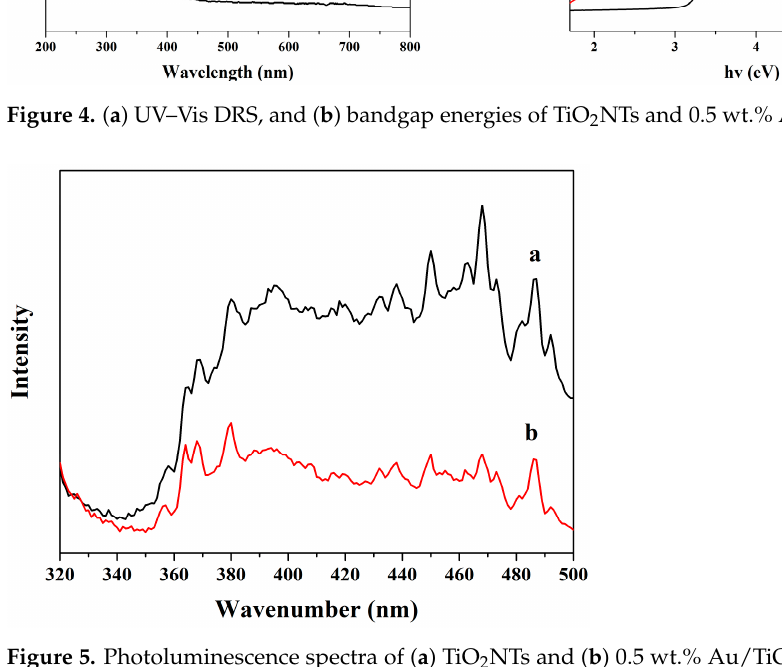
Figure 5. Photoluminescence spectra of ( a ) TiO 2 NTs and ( b ) 0.5 wt.% Au/TiO 2 NTs in the powder form at 300 nm excitation.